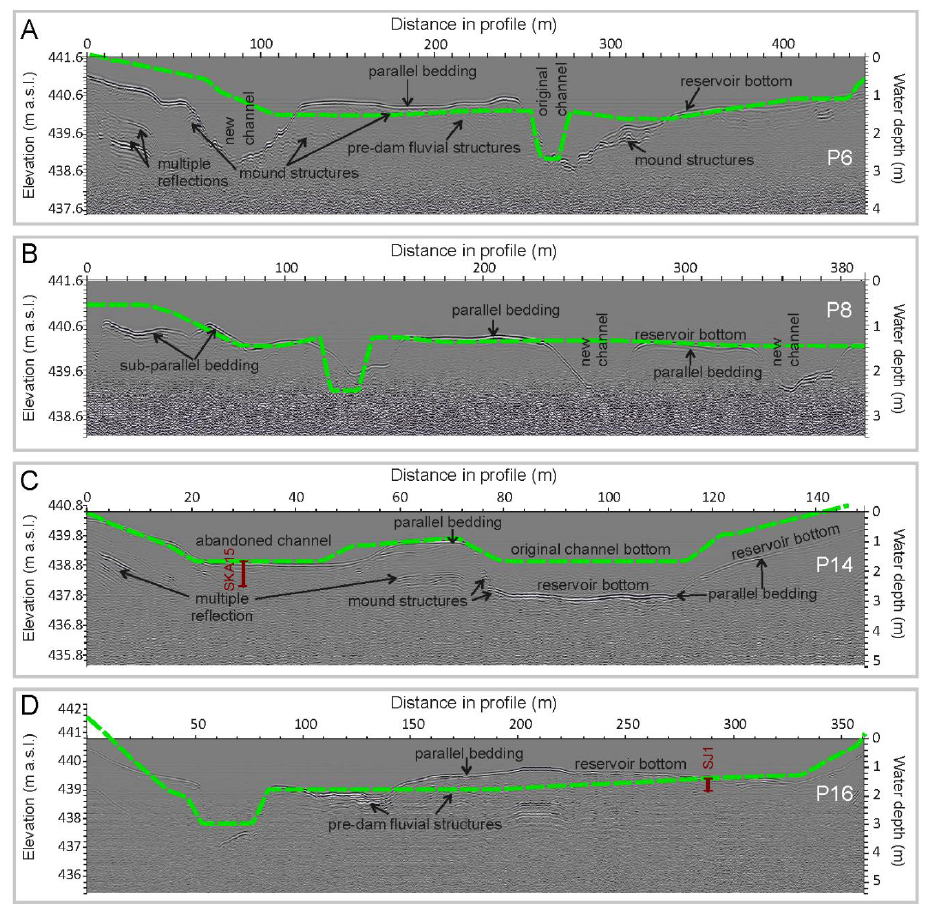
Figure 4. Ground-penetrating radar (GPR) images of selected transect profiles in the Skalka inflow. The positions of profiles are shown in Figure 2. ( A ) Transect profile P6, ( B ) transect profile P8, ( C ) transect profile P14, ( D ) transect profile P16.